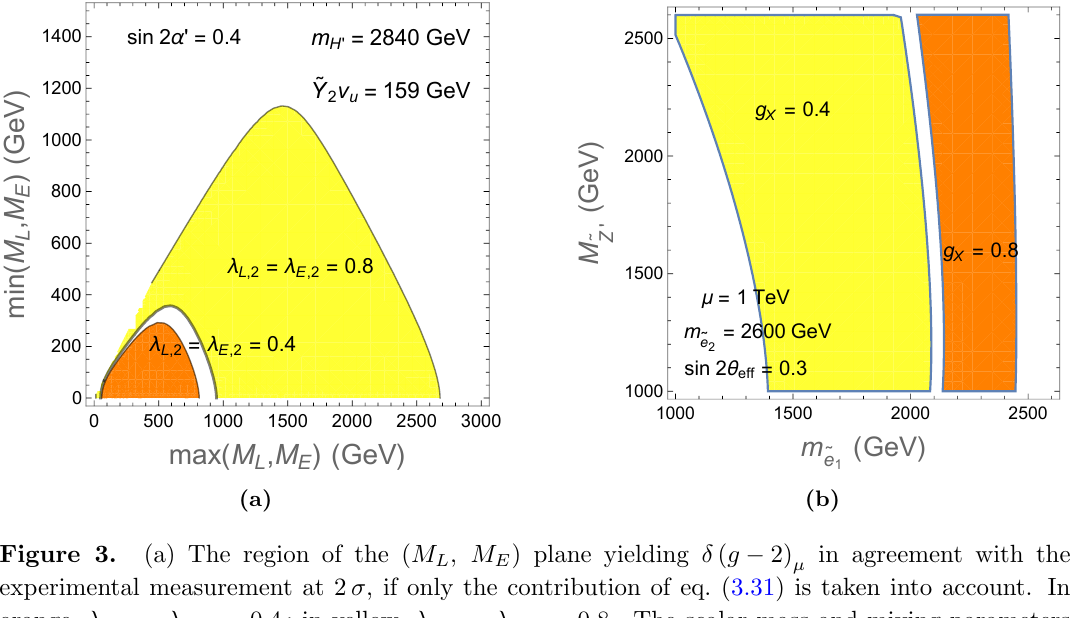
in agreement with the (cid:22) , M ~ ) plane the parameter space in Z 0 1 at the 2 (cid:27) level, if only the contribution of eq. (3.34) (cid:22)